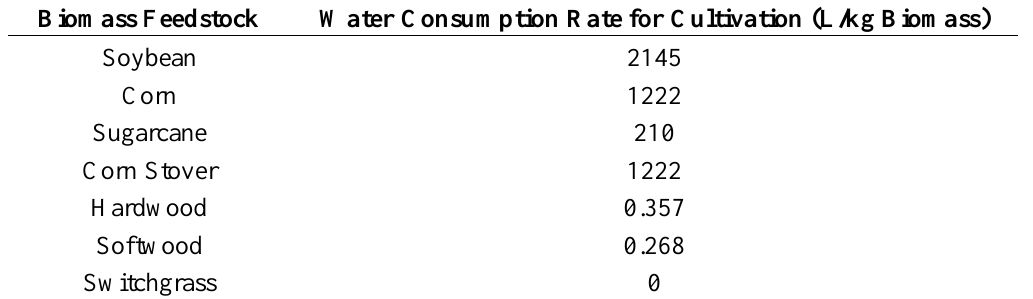
Table 1. Water consumption rates for cultivation of the biomass feedstocks available in this